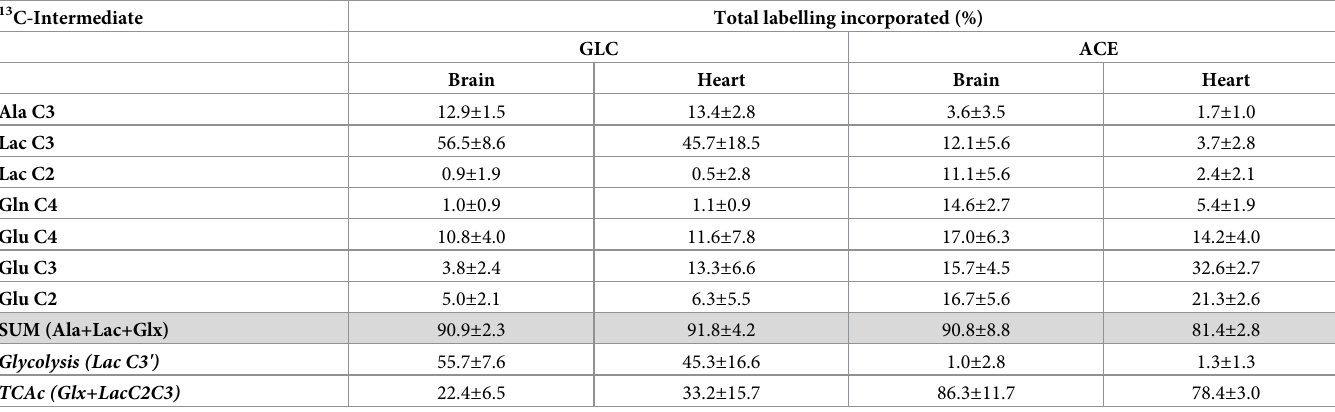
Table 2. Estimations of 13 C-labelling incorporation in brain and heart